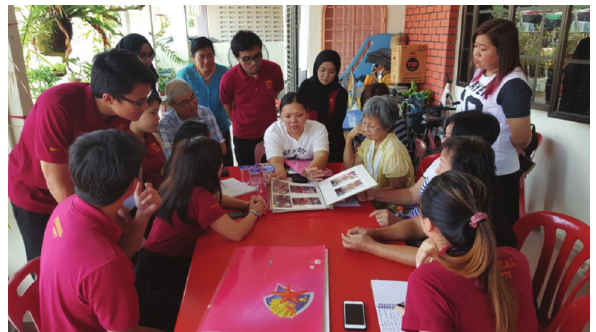
Laparoscopic surgery is one of the most common Fig. 2: procedure where surgeons can benefit from surgical simulation using